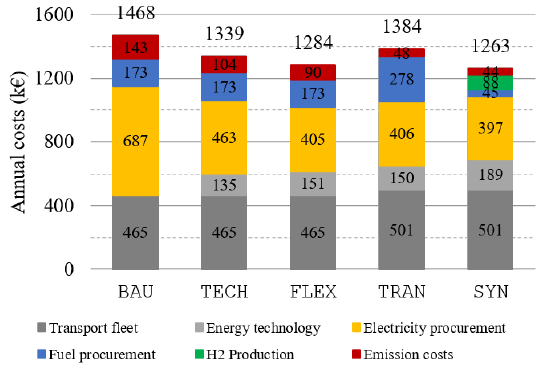
Figure 6. Costs by component of the principle scenarios. Table 1. Optimal PV capacities and generation utilization (self-consumption, export and curtail), energy imports and emissions of the principle scenario set.